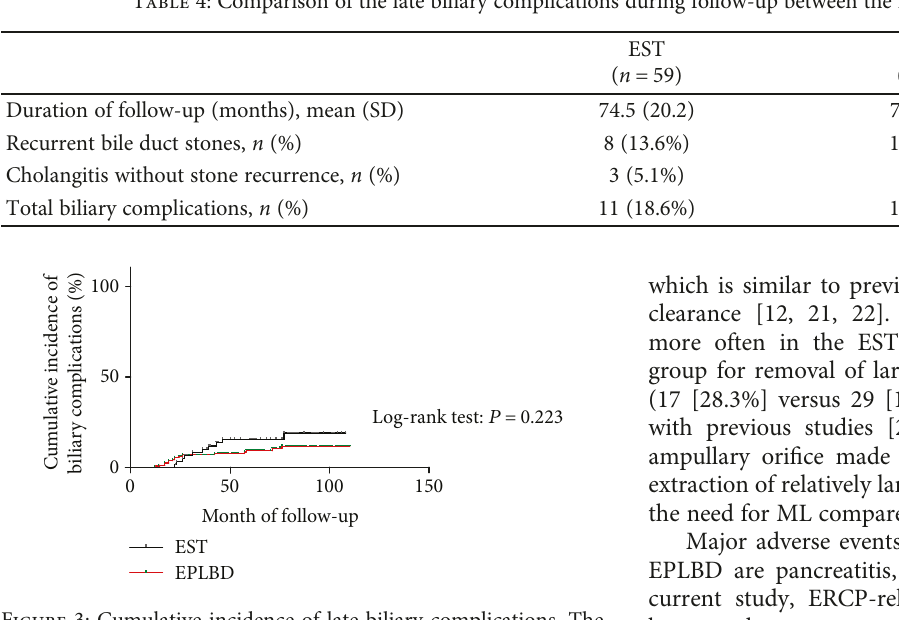
Table 4: Comparison of the late biliary complications during follow-up between the EST and EPLBD groups.